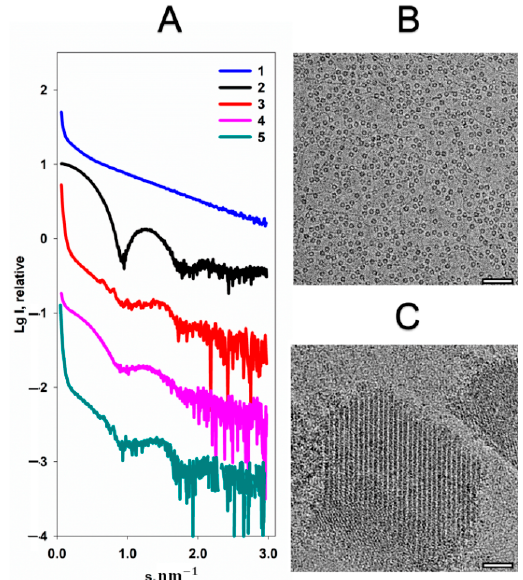
Figure 1. The effect of MgCl 2 on the structure of Dps-DNA co-crystals. ( A ) Experimental SAXS curves from: 1—DNA, 2—Dps, 3—Dps-DNA complex, 4—Dps-DNA co-crystals with addition of 20 mM MgCl 2 , 5—Dps-DNA co-crystals after addition of 20 mM MgCl 2 and 20 mM EDTA. Cryo-EM data of Dps-DNA co-crystals after addition of 20 mM MgCl 2 ( B ) and Dps-DNA co-crystals after addition of 20 mM MgCl 2 and 20 mM EDTA ( C ). Bar length is 50